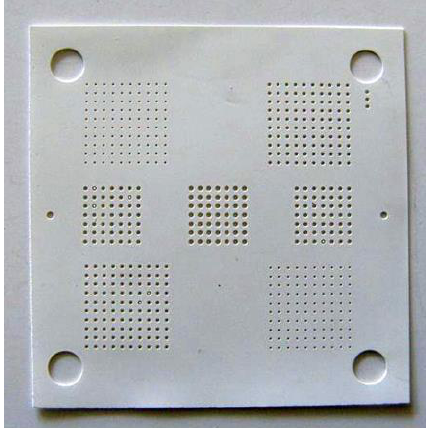
Figure 1. One Ferro A6M-E tape layer where hole matrixes of different diameter are placed. The top left and the lower right matrixes are made up of 116 µm holes, the top right and the lower left matrixes of 174 µm holes, the middle line left and right matrixes are made up of 232 µm holes and the middle matrix is made up of 291 µm holes all with a pitch of 573 µm. The dimensions are given before firing intended for a 15.6%